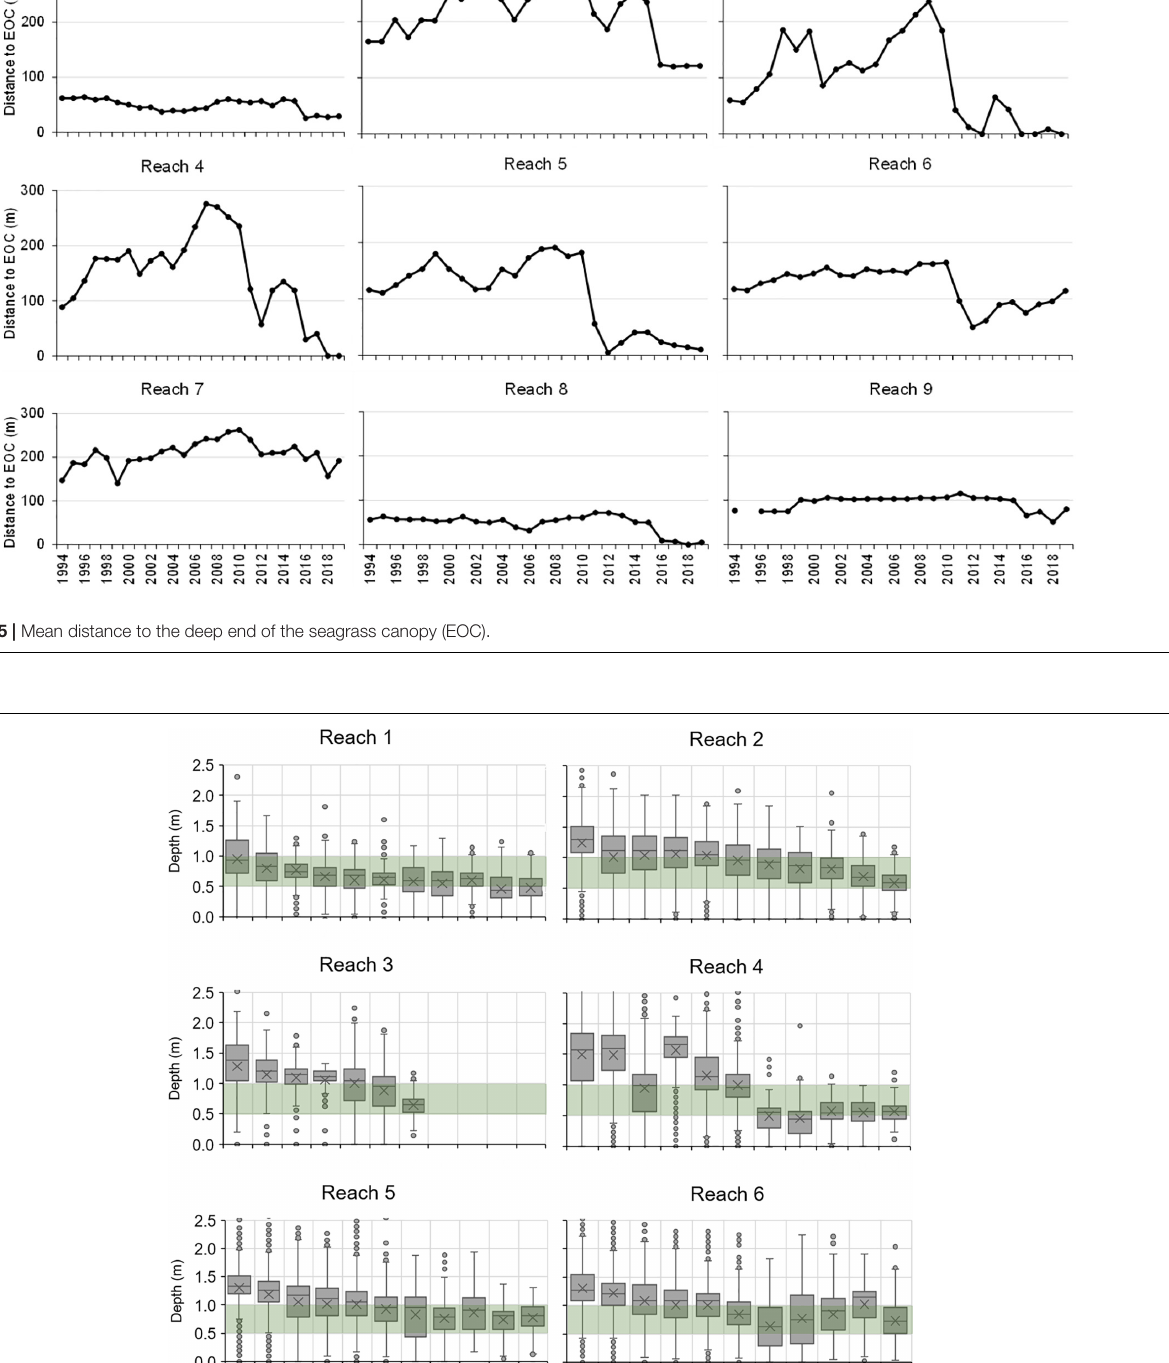
Frontiers in Marine Science |